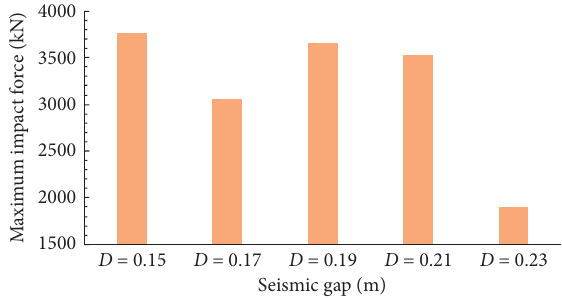
Figure 12: Influence of gap size on impact force (PGA �